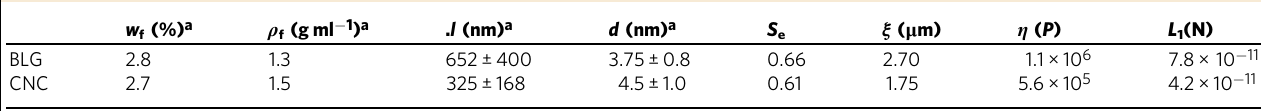
Fig. 1 Slow – fast and smooth relaxation dynamics corresponding to BLG and CNC, respectively. a – f Time-series snapshots of BLG microscopy (POM) images. g – l Time-series snapshots of CNC microscopy (POM) images. The images shown in panels a – l were experimentally acquired using the LC PolScope device and different colors represent different director fi eld orientations which are appreciated according to the colormap depicted as the inset in the panel f . See Supplementary Note 1 for the detailed discussion on the mapping between fi bers orientation and colormap. Note that the colormap shown as the inset in the panel f is applicable for all the microscopy images studied in this work. Over the relaxation time, cholesteric fi ngerprints progressively propagate into the unwound state (dark zone). Times elapsed from the beginning of relaxation are shown on top-left corners; min and h stand for minutes and hours, respectively. m Experimental observation and numerical simulation on the normalized relaxation progress curve, R , for BLG. The labels B 1 to B 6 correspond to Fig. 2. n Experimental observation and numerical simulation on the normalized relaxation progress curve, R , for CNC. The labels C 1 to C 4 correspond to Fig. 3. o The coordinate system used throughout this study along with a schematic illustration of a capillary tube indicating the ground state of fi bers con fi guration in a circular cross-section in the xz -plane, known as concentric, and the averaged fi bers con fi guration in a lateral plane in the xy - plane, known as chiral monodomain. The averaged fi bers con fi guration on the lateral plane is representative of the colormap PolScop analysis shown in the panels a – l . Table 1 BLG and CNC properties obtained by the experiment and/or